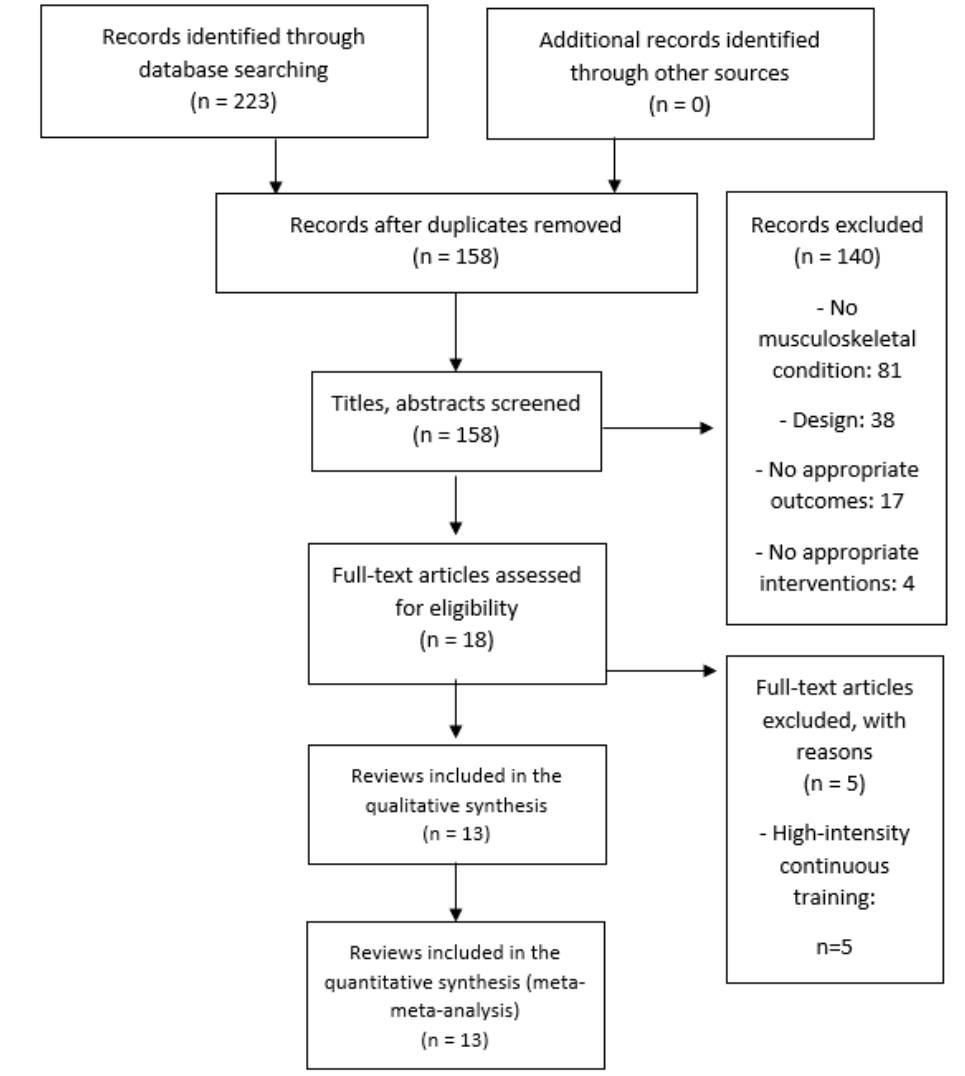
Figure 1. PRISMA Flowchart for selecting studies.